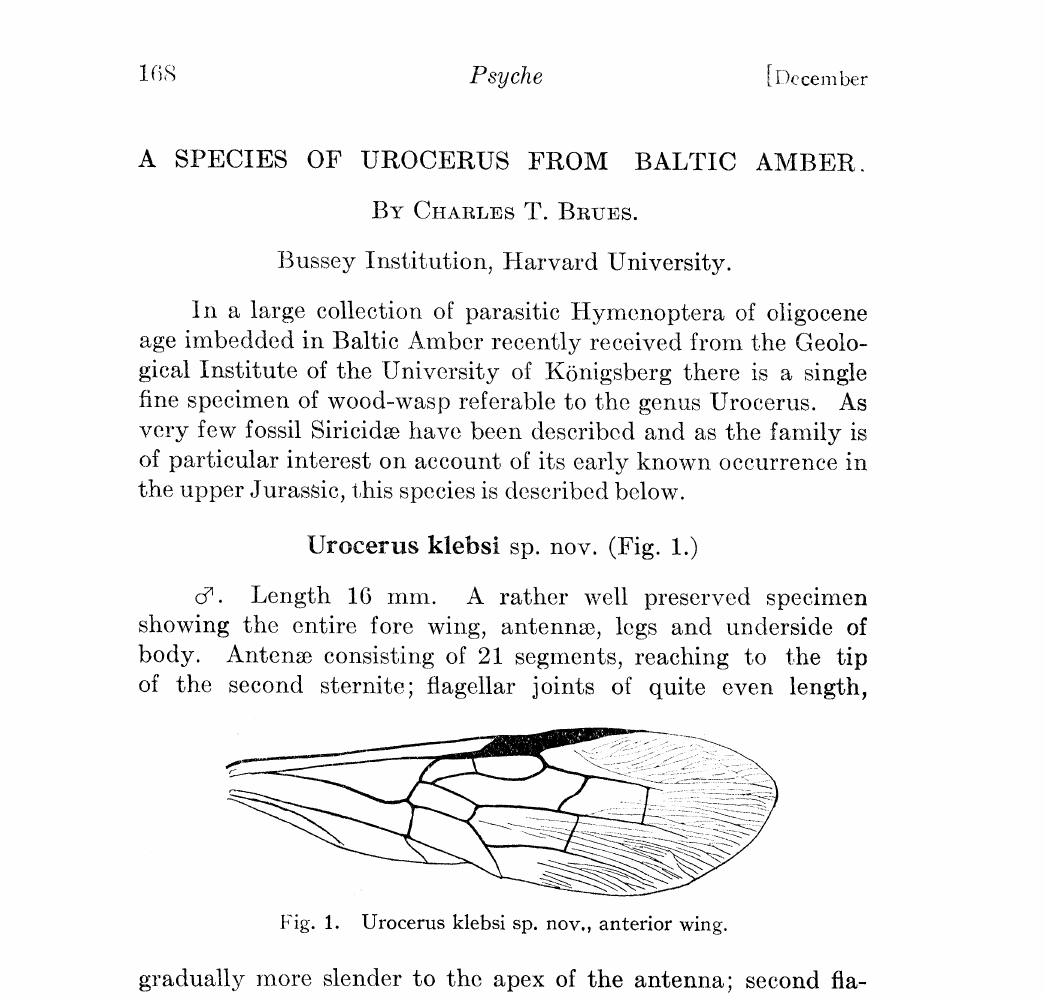
Fig. 1. Urocerus klebsi sp. nov., anterior